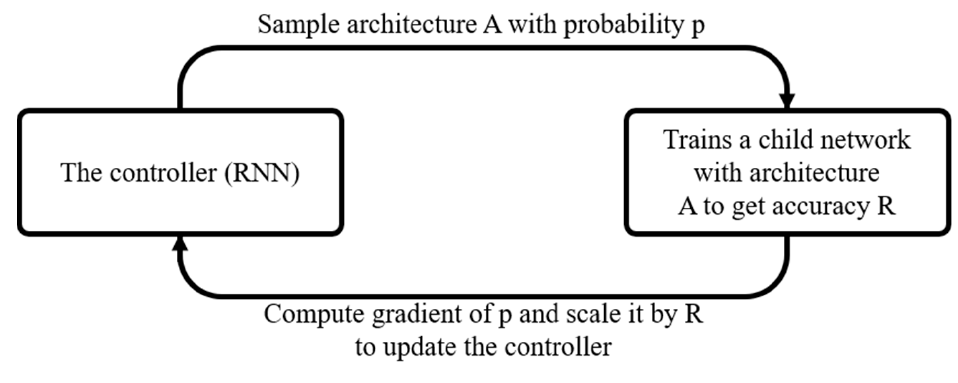
Figure 7. NASNet operation [25].